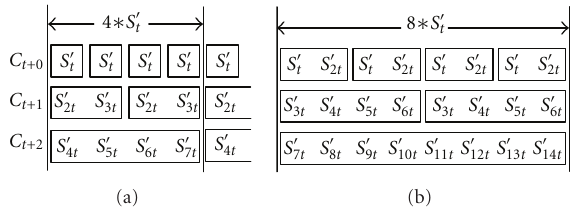
Figure 5: The binomial relations on the fast broadcasting